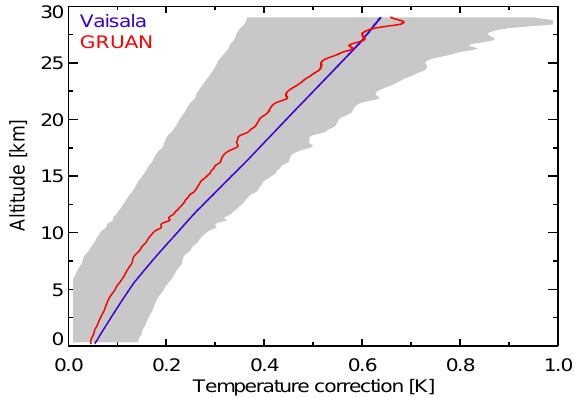
Figure 7. Comparison of the GRUAN and Vaisala correction mod- Fig. 7. Comparison of the GRUAN and Vaisala correction models for the radiation temperature error. Blue els for the radiation temperature error. Blue trace: Vaisala correc- trace: Vaisala correction profile (DigiCora version 3.64), red trace: GRUAN correction profile. The grey bar tion profile (DigiCora version 3.64); red trace: GRUAN correc- represents the uncertainty estimate of the GRUAN temperature correction. The correction profiles are evaluated tion profile. The grey bar represents the uncertainty estimate of the for a sounding performed at Lindenberg on 17 September 2013 at 12:00UTC, maximum solar zenith angle GRUAN temperature correction. The correction profiles are evalu- during the sounding: 36.5 ◦ . ated for a sounding performed at Lindenberg on 17 September 2013 at 12:00UTC; maximum solar zenith angle during the sounding: